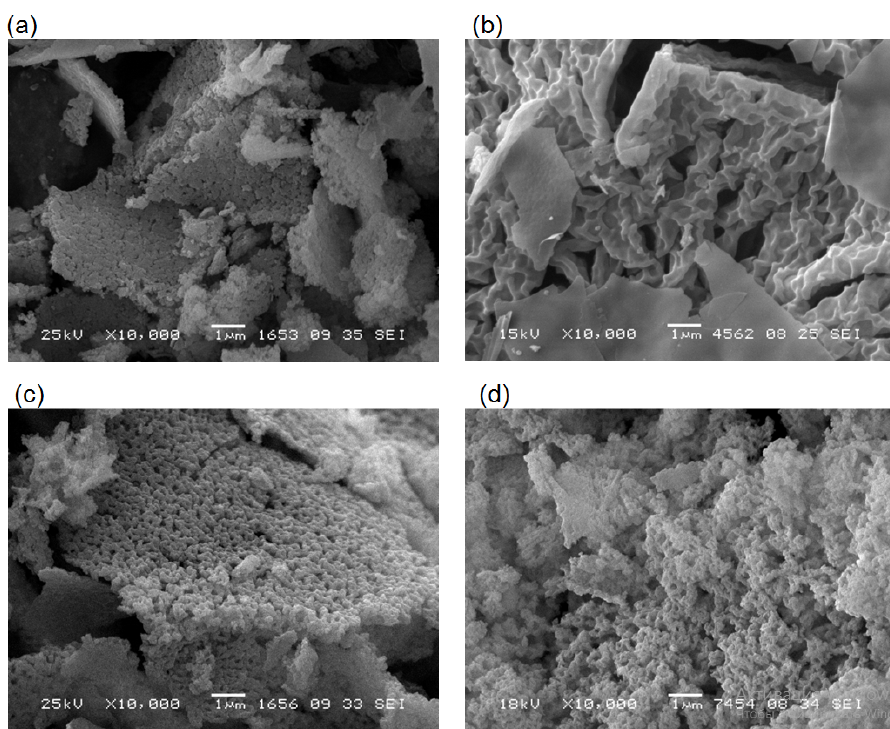
9 of 40 Figure 4. Effect of Ni molar fraction ( a ) and M/Ce molar ratio ( b ) on the specific surface area of